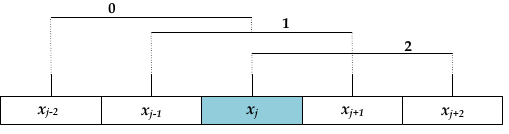
Figure 1: Spatial domain in reconstruction.